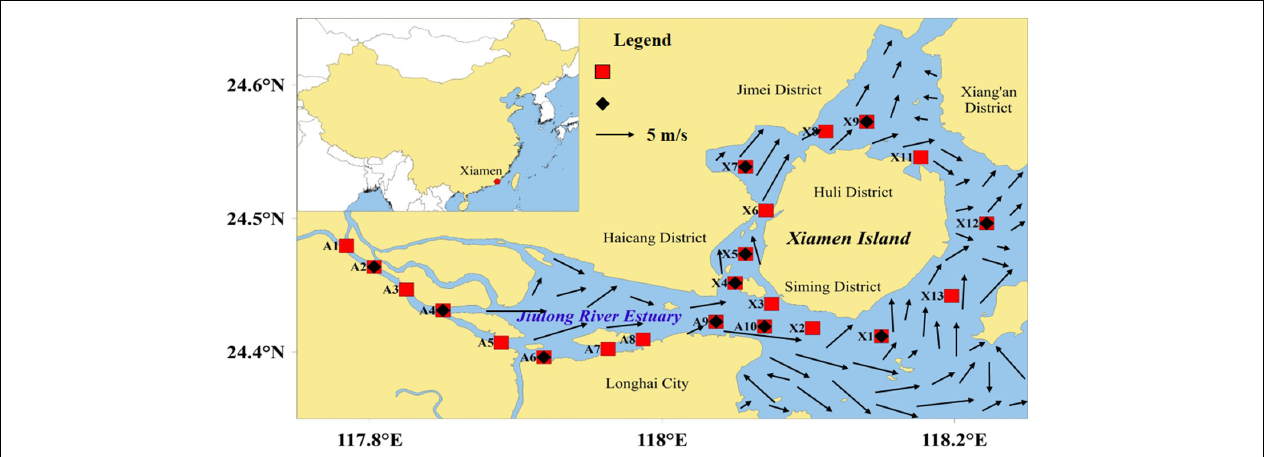
FIGURE 1 | Map of the sampling sites. X1-X9 and X11-X13 are located in Xiamen Bay, and A1-A10 are located in the Jiulong River Estuary. Pumping samples were collected at all sites, and trawling samples were collected at half of the sites, marked in